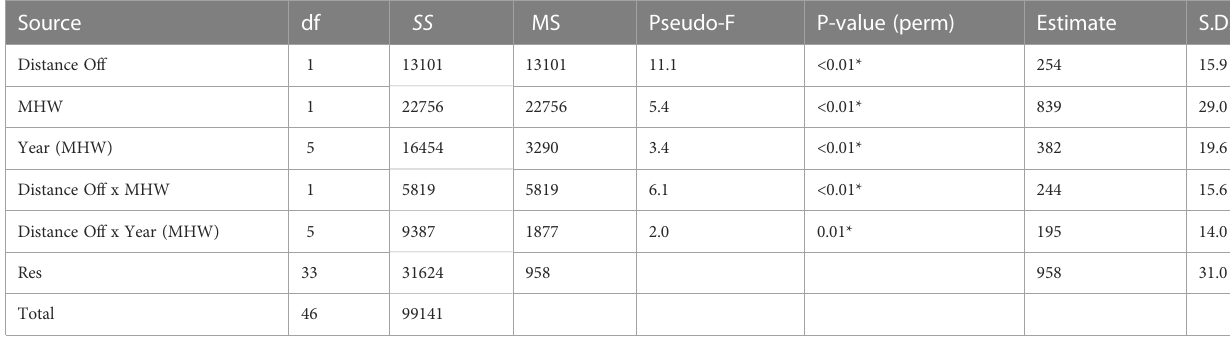
TABLE 3 PERMANOVA